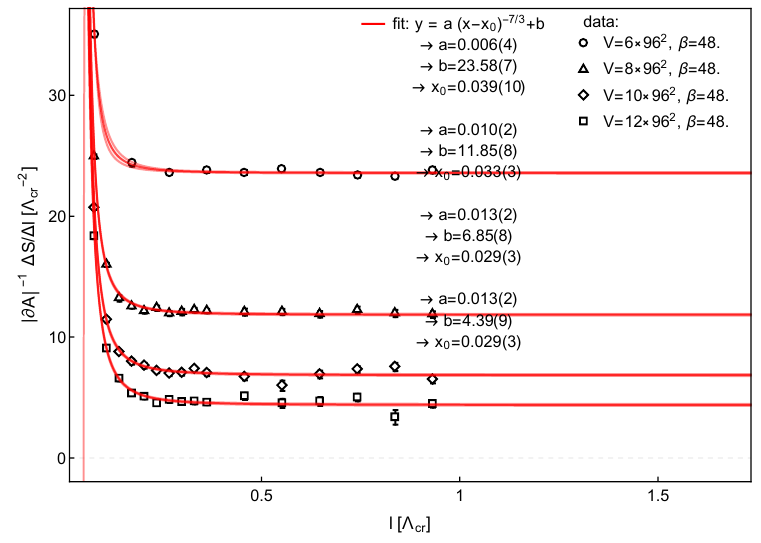
Figure 2. The derivative of the entanglement entropy wrt. strip width (cid:96) in three-dimensional SU(2) Yang-Mills theory. The di ff erent curves represent increasing temperature (bottom-up). The fit here is just to guide the eye, more refined analyses reveal the IR (large- (cid:96) ) ∂ (cid:96) S EE ∼ T 7 / 3 and UV (small- (cid:96) ) ∂ (cid:96) S EE ∼ (cid:96) − 7 / 3 behaviors.